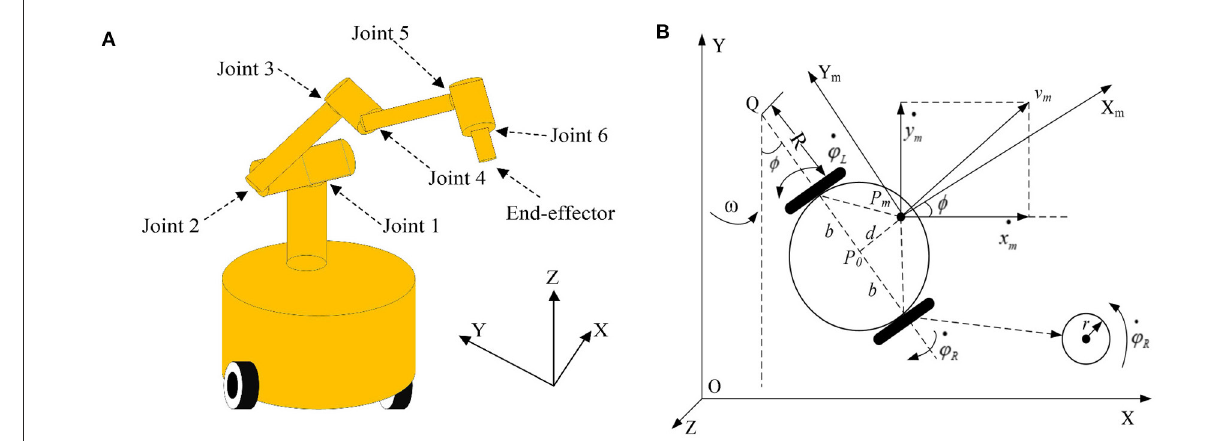
FIGURE16 Modeling of the RM. (A) Three-dimensional structure of the RM. (B) Geometrical model of the RM.